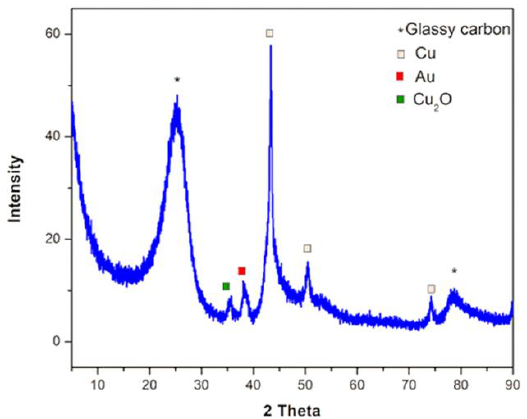
Figure 5. HR-STEM micrographs in ( A ) SEM, ( B ) TEM, and ( C ) ZC mode; ( D ) EDX analysis and ( E ) interplanar space determination.